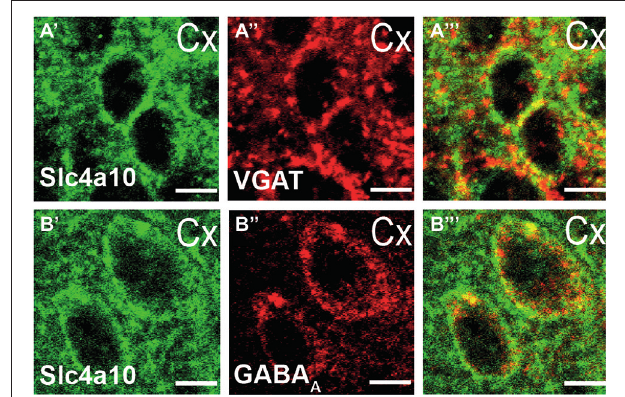
FIGURE 3 | Synaptic expression of Slc4a10 in the cortex. (A (cid:48) –A (cid:48)(cid:48)(cid:48) ) Overlap of Slc4a10 and VGAT, a marker for GABAergic presynapses (green: Slc4a10, red: VGAT). (B (cid:48) –B (cid:48)(cid:48)(cid:48) ) Slc4a10 co-localizes also with the postsynaptic GABA A -receptor in cortical neurons (green: Slc4a10, red: GABA A - α 5).